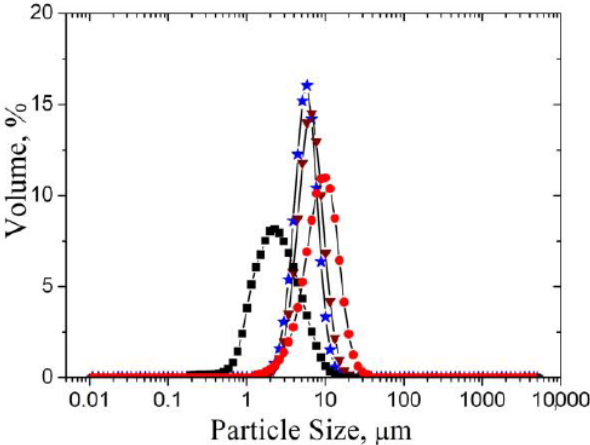
Figure 2. Particle size distribution for initial FeO particles (square) and aggregates obtained at dose op as a function of the ionic group content, TMAP 0.7 –P (circle); TMAP 0.4 –P (inverted triangle); TMAP 0.2 – P (star); and settling time 120 min. The particle size distribution curves represent the mean of three independent measurements.